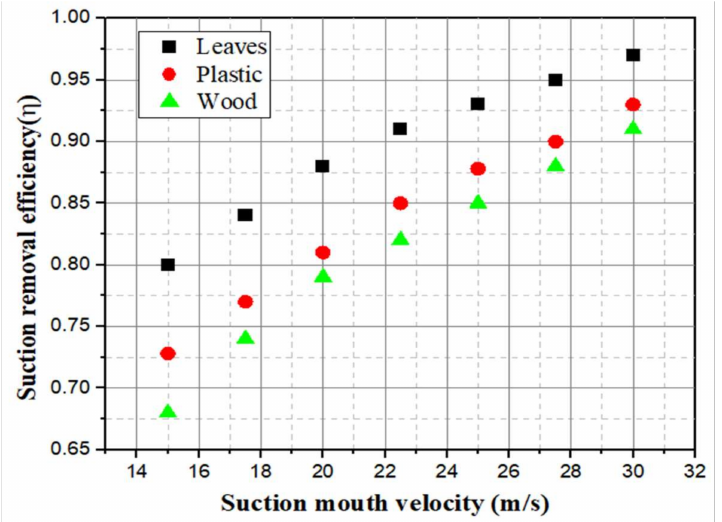
Figure 10. Experimental results of the effect of increasing the velocity of the airflow in the suction port on the efficiency of particle